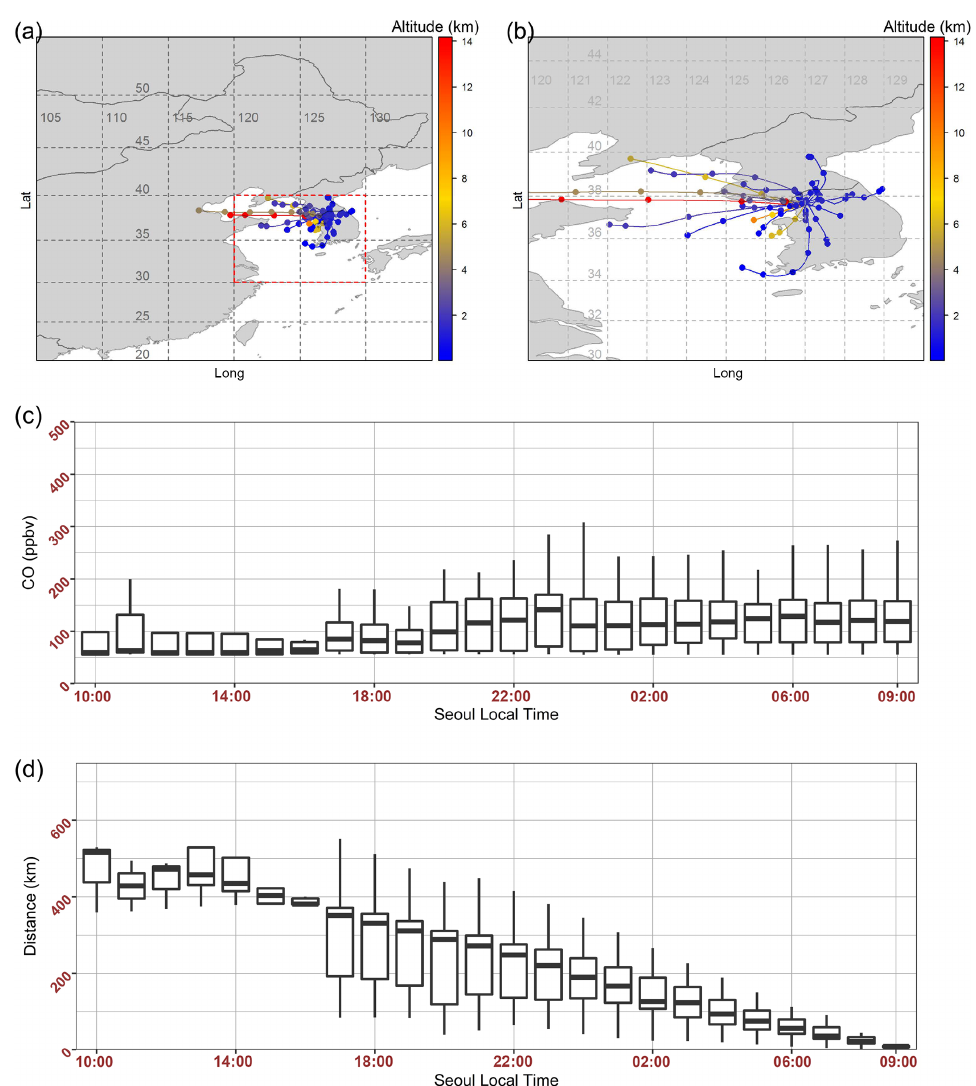
Figure 9. C-TRAIL output for the stagnant period (SP) for Seoul as the receptor: (a) 24h trajectories of packets for the entire domain, (b) 24h trajectories of packets for the zoomed area in South Korea, (c) boxplots of the CO concentrations of all packets at each hour before they reached Seoul, and (d) boxplots of packet distances from Seoul at each hour before the packets reached